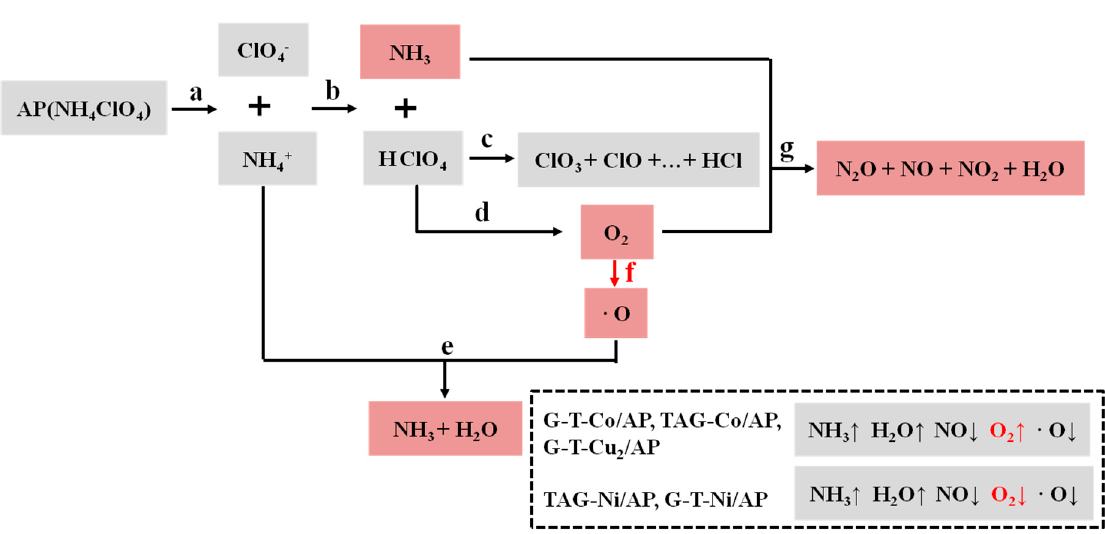
Figure 4. Thermal decomposition mechanisms of AP under the catalytic effects of TAG-M complexes (arrow up means increase and arrow down means decrease).